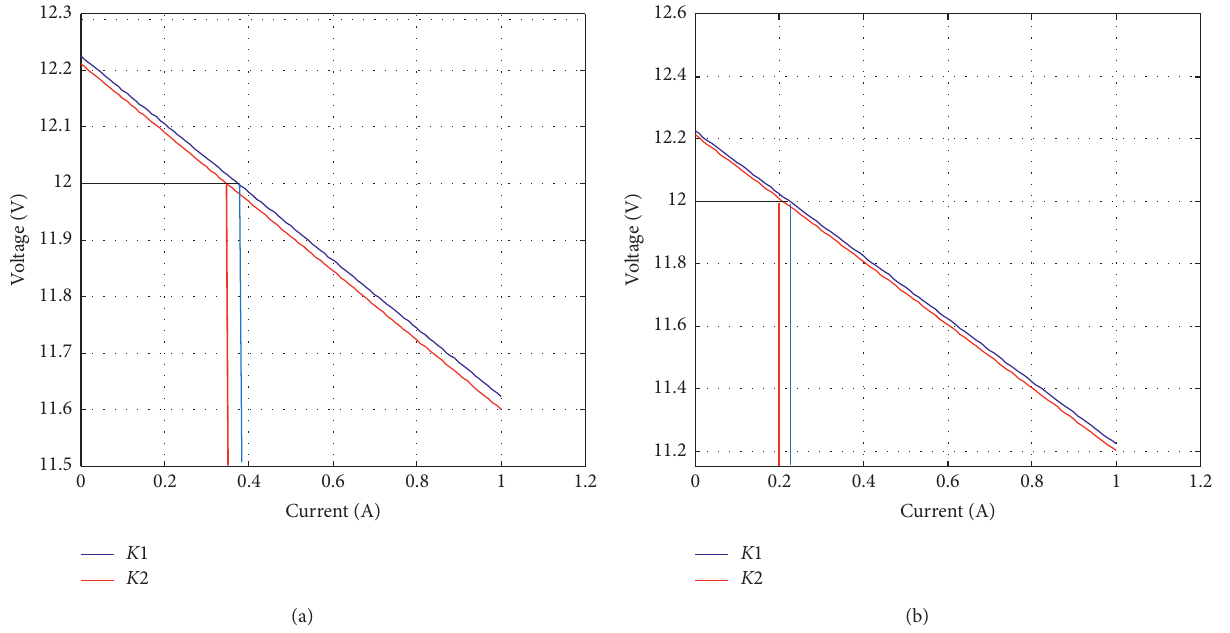
Figure 3: Load regulation characteristics of two parallel-connected boost converters. (a) Converters connected directly to a resistive load. (b) Converters connected to a resistive load through cable